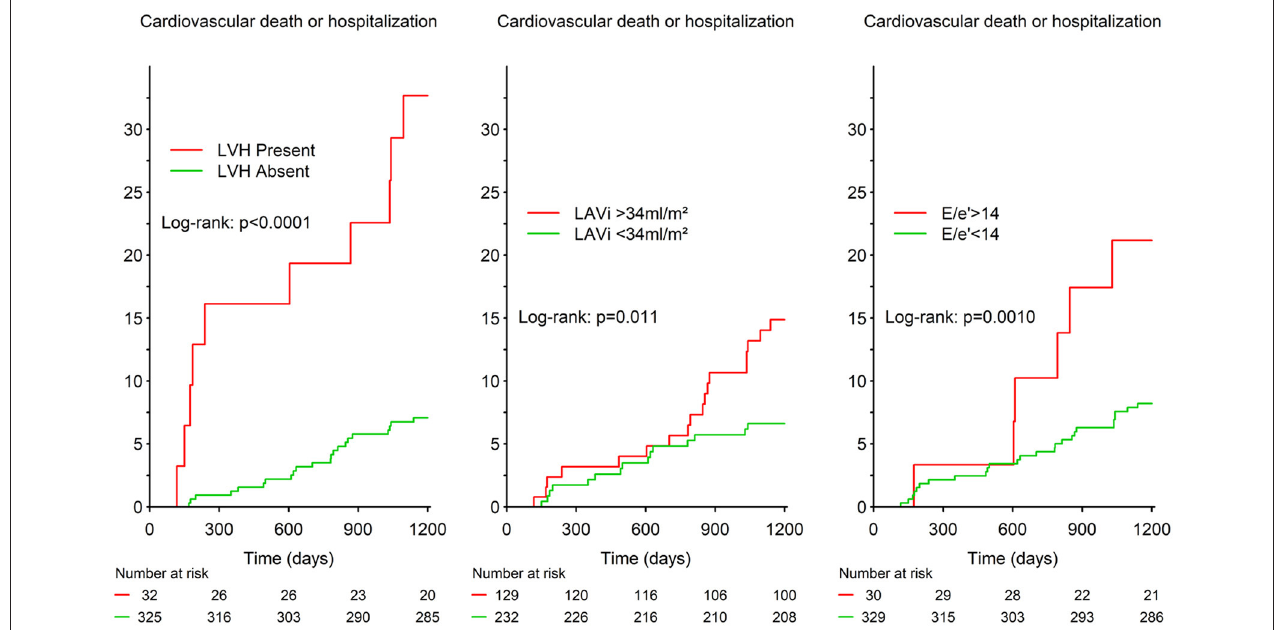
FIGURE 1 | Survival curves for the primary outcome according to presence/absence of cardiac structure and function abnormalities in the RA Porto study. LVH, left ventricular hypertrophy; LAVi, left atrial volume